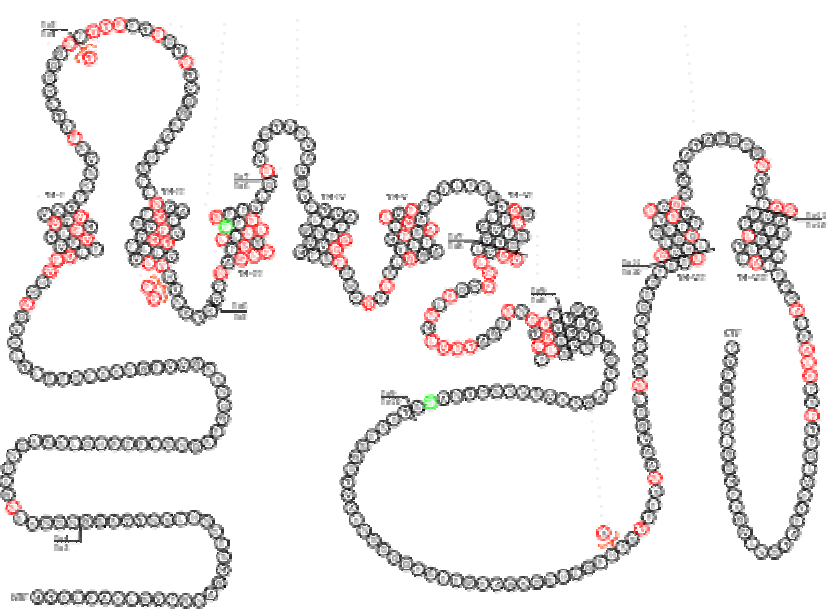
FIGURE 3. Schematic representation of PSEN1. Amino acids with pathogenic missense mutations are shown in red and amino acids with not-pathogenic missense mutations are in green. For each mutation a hyperlink to the AD mutation database (http://molgen- www.uia.ac.be/ADMutations/) is